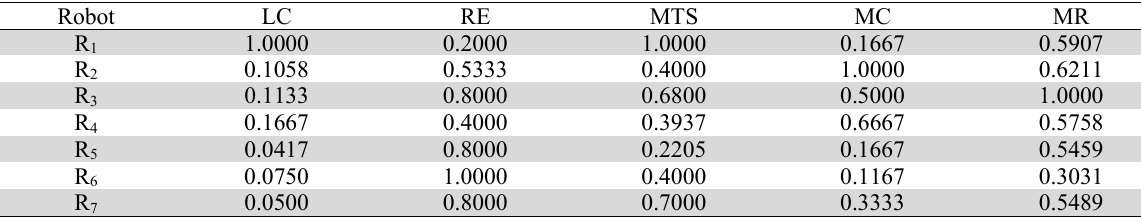
Normalized decision matrix for WAS, WPM and WASPAS methods Robot